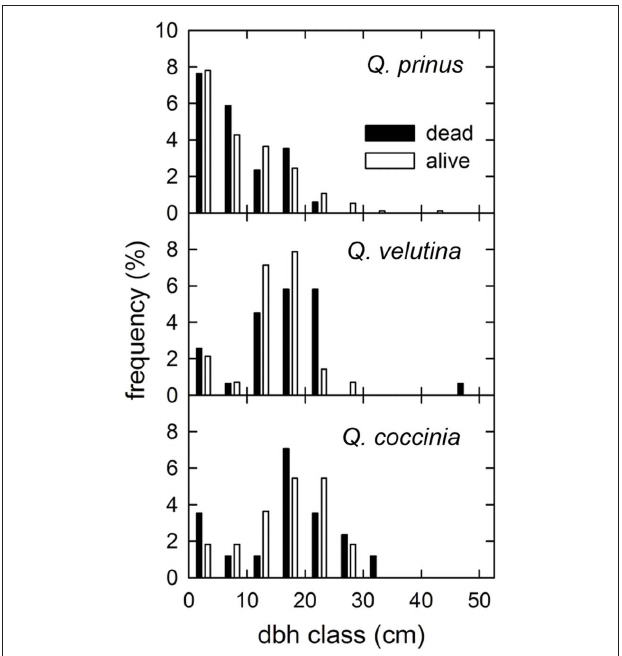
Figure 3 | Percentage of trees of each species within the measurement plot alive (white bars) and dead (black bars) in 2008 after the previous year’s gypsy moth defoliation for each diameter in breast height (dbh) class.